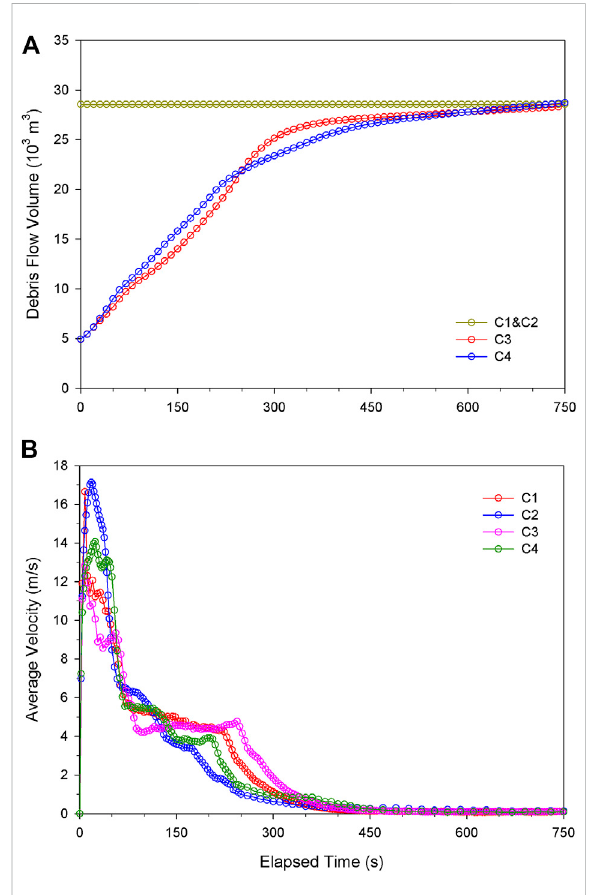
FIGURE 8 Simulated time curves of the (A) debris fl ow volume and (B) average velocity of the July 23 debris- fl ow event.